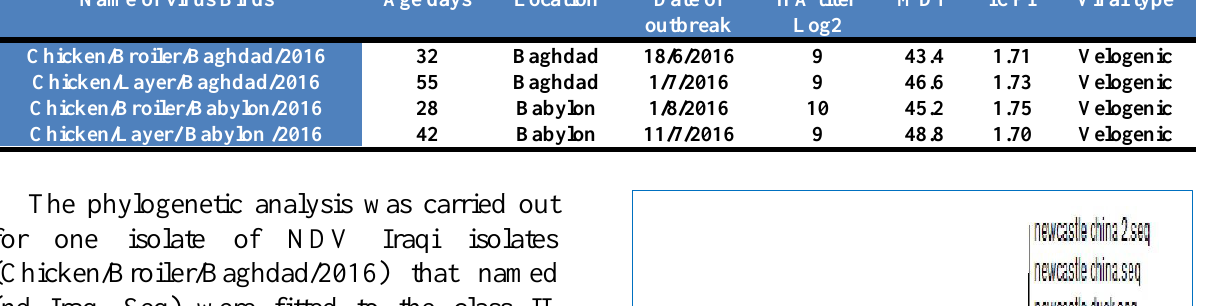
Table, 1: Complete History, HA titers and ICPI values of each NDV isolate. Name of virus Birds Age days Location Date of